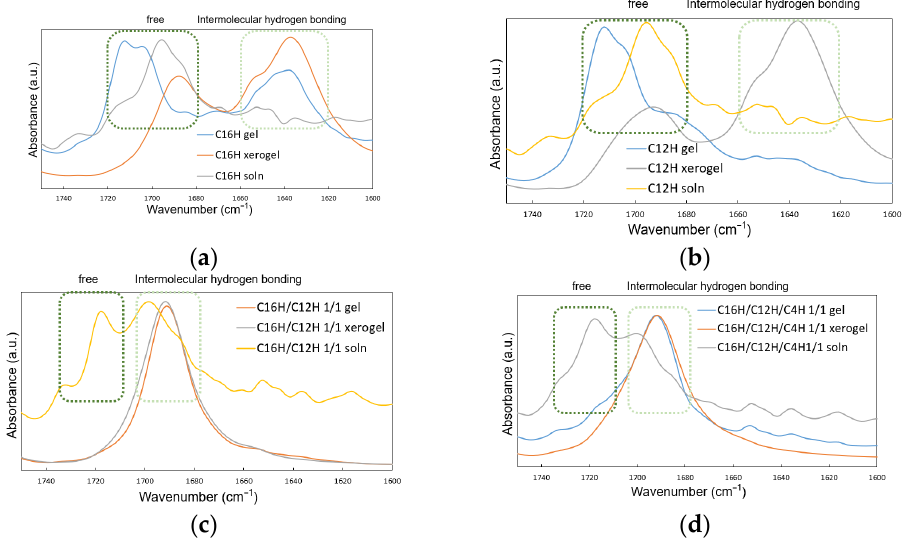
Figure 9. ATR–FTIR spectra of the N -alkylhydantoins in different states (a gel, aqueous solution, and